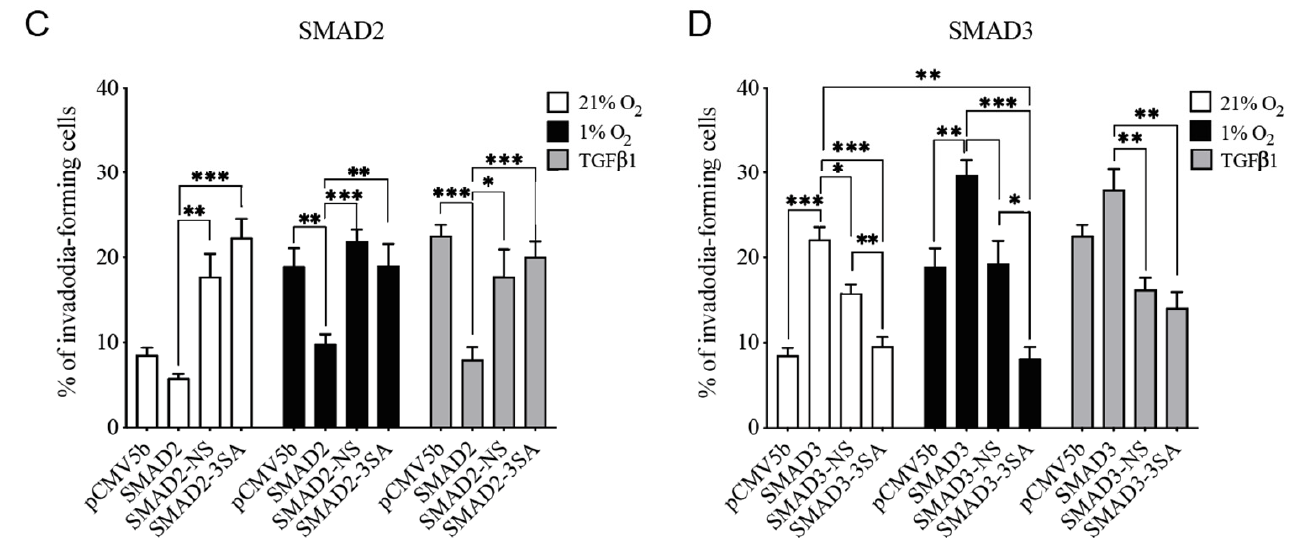
Figure 5. SMAD2 and SMAD3 Depend on SARA Binding to Modulate Cancer Cell Invasion. HT- 1080 cells were transiently transfected with wild-type, C-terminal mutant (3SA), or SARA-binding mutant N339/381S (NS) SMAD2 or SMAD3 constructs, using empty vector (pCMV5b) as a control. ( A ) Representative Western blot showing overexpression specificity and efficacy of each construct. ( B ) Representative co-immunoprecipitation assays showing the reduction of SARA-binding to each SMAD NS constructs. Densitometric analysis of co-IP SARA/SMAD2 or SMAD3 IP was performed. C , D ) Percentage of invadopodia-forming HT-1080 cells transfected with SMAD2 ( C ) or SMAD3 ( D ) constructs after 10 h incubation under normoxic (21% O 2 ), hypoxic (1% O 2 ) or TGF- β 1 supplemented (1 ng/mL) condition ( n = 3–5). Data are presented as mean ± SEM. * p < 0.05; ** p < 0.01; *** p < 0.001.